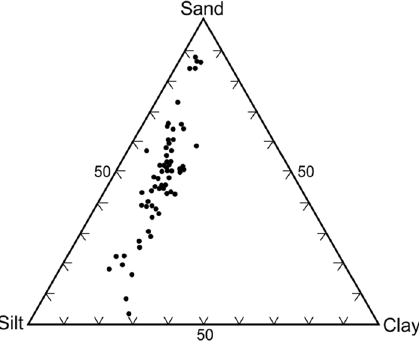
Fig. 7 Malay Basin core sieve analysis displayed in ternary diagram